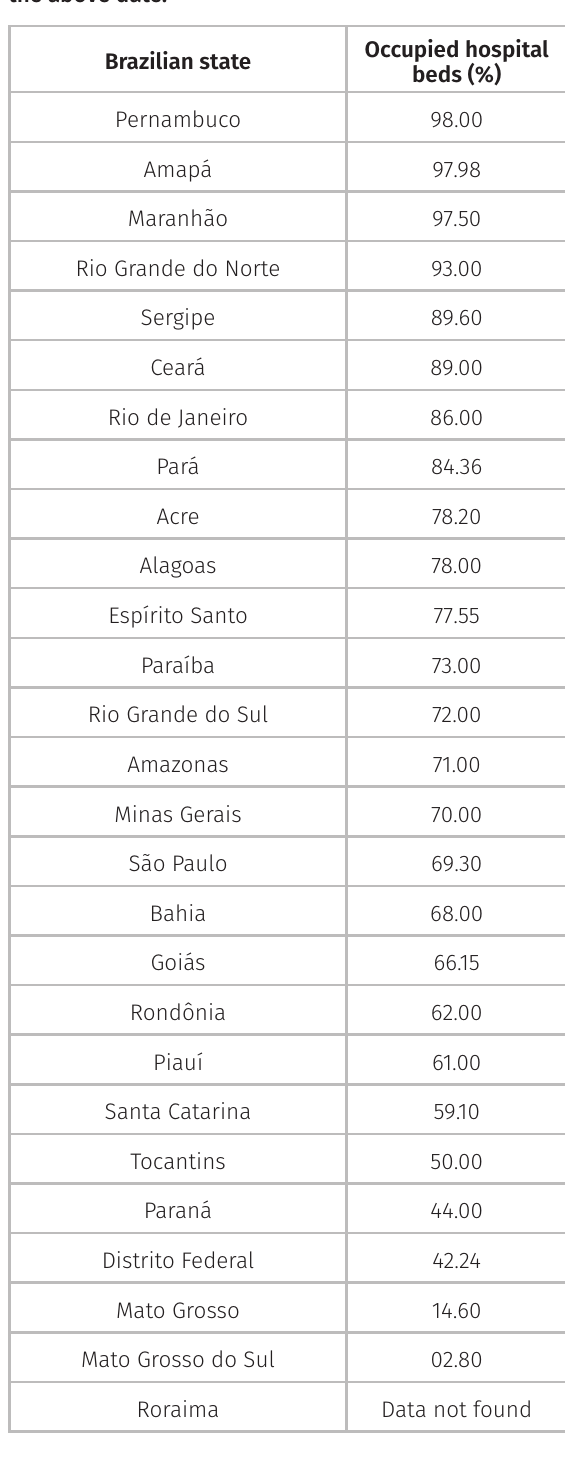
Table II. Estimative of occupied hospital beds in May 30 th , 2020 in Brazilian public hospitals. Data were found in the Health Secretaries sites of each state at the above